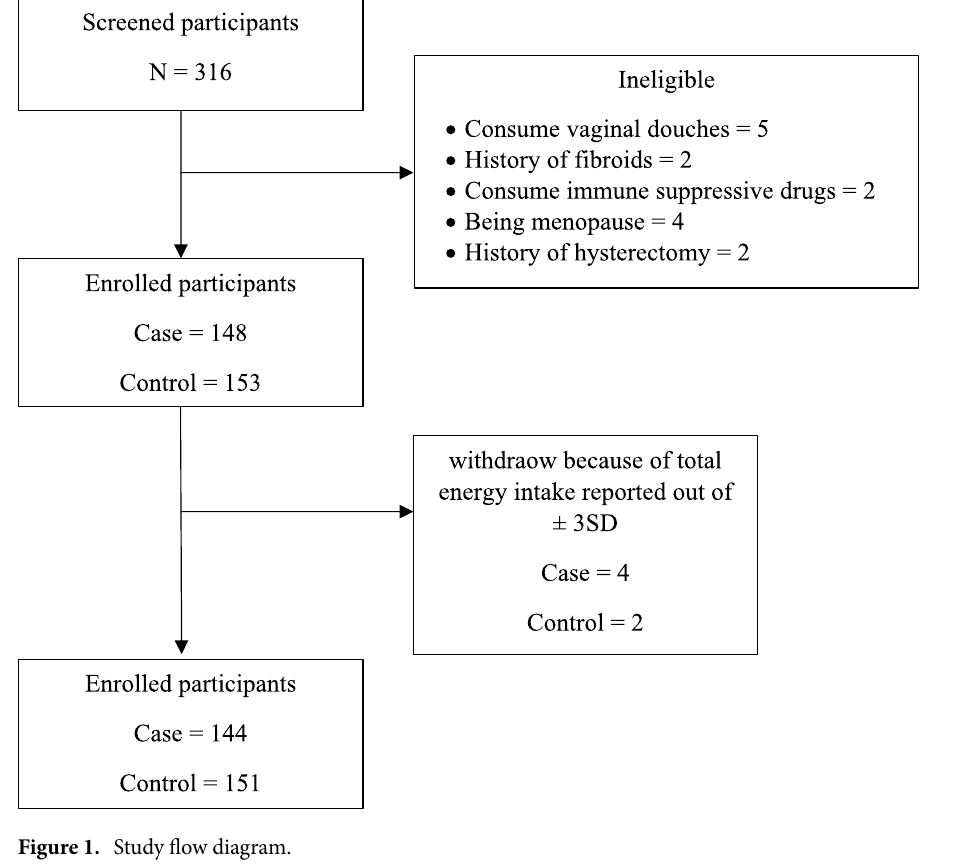
Figure 1. Study flow